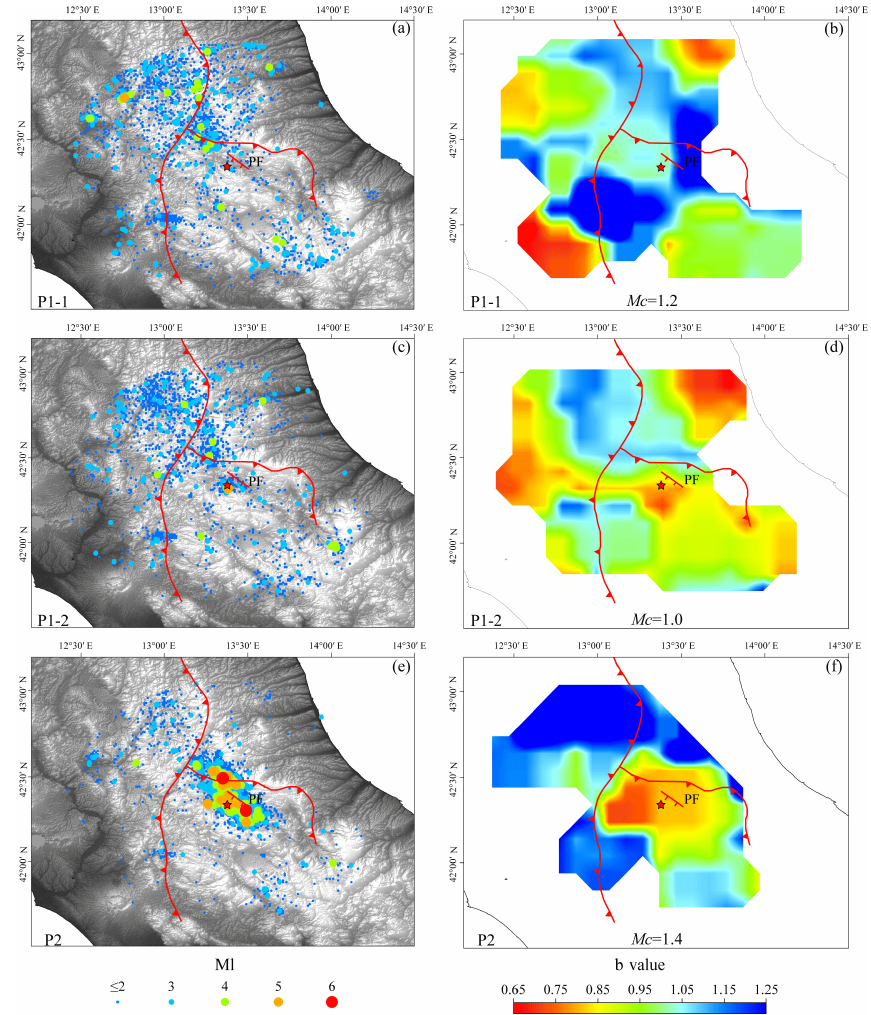
Figure 12. Spatial distributions of epicenters (a, c, e) and b value (b, d, f) before and after the mainshock of the L’Aquila earthquake at three-staged phases (the red star and the red lines represent the mainshock and main fault system,